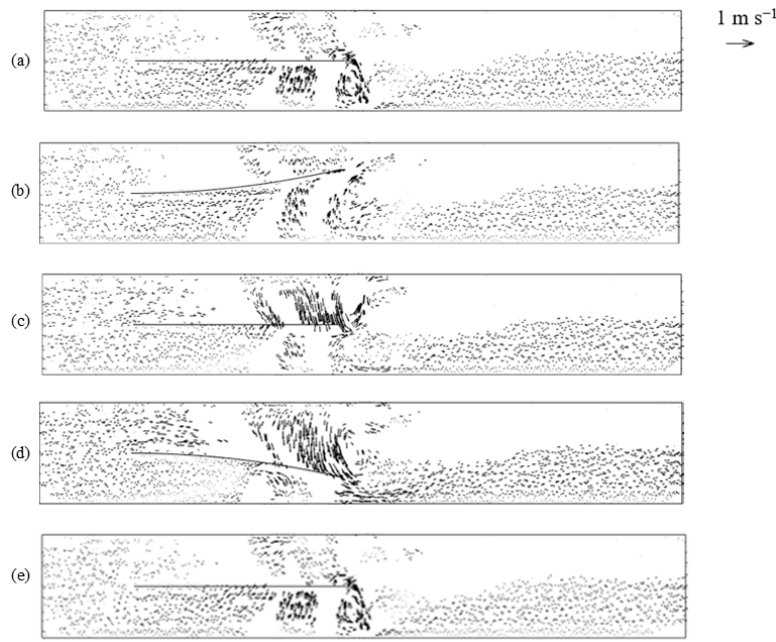
Figure 7. Temperature contour of the heated surface: ( a ) without blade; ( b ) Phase 0 π ; ( c ) Phase π /2.